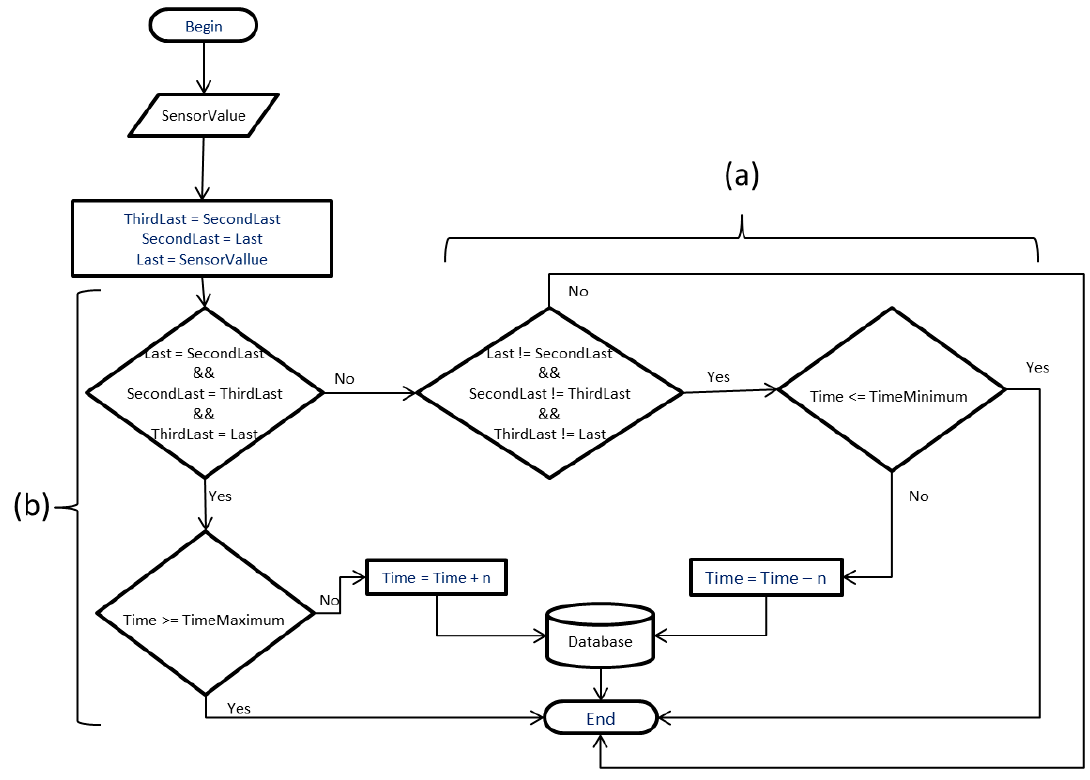
Figure 5. Update of the summarization times in the database.